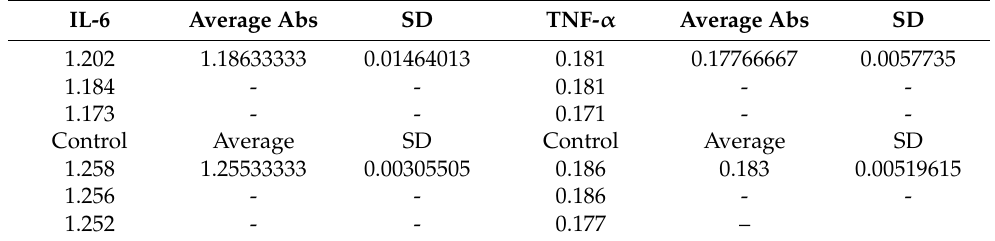
Table 5. IL-6 and TNF- α standard optical density against different concentrations.